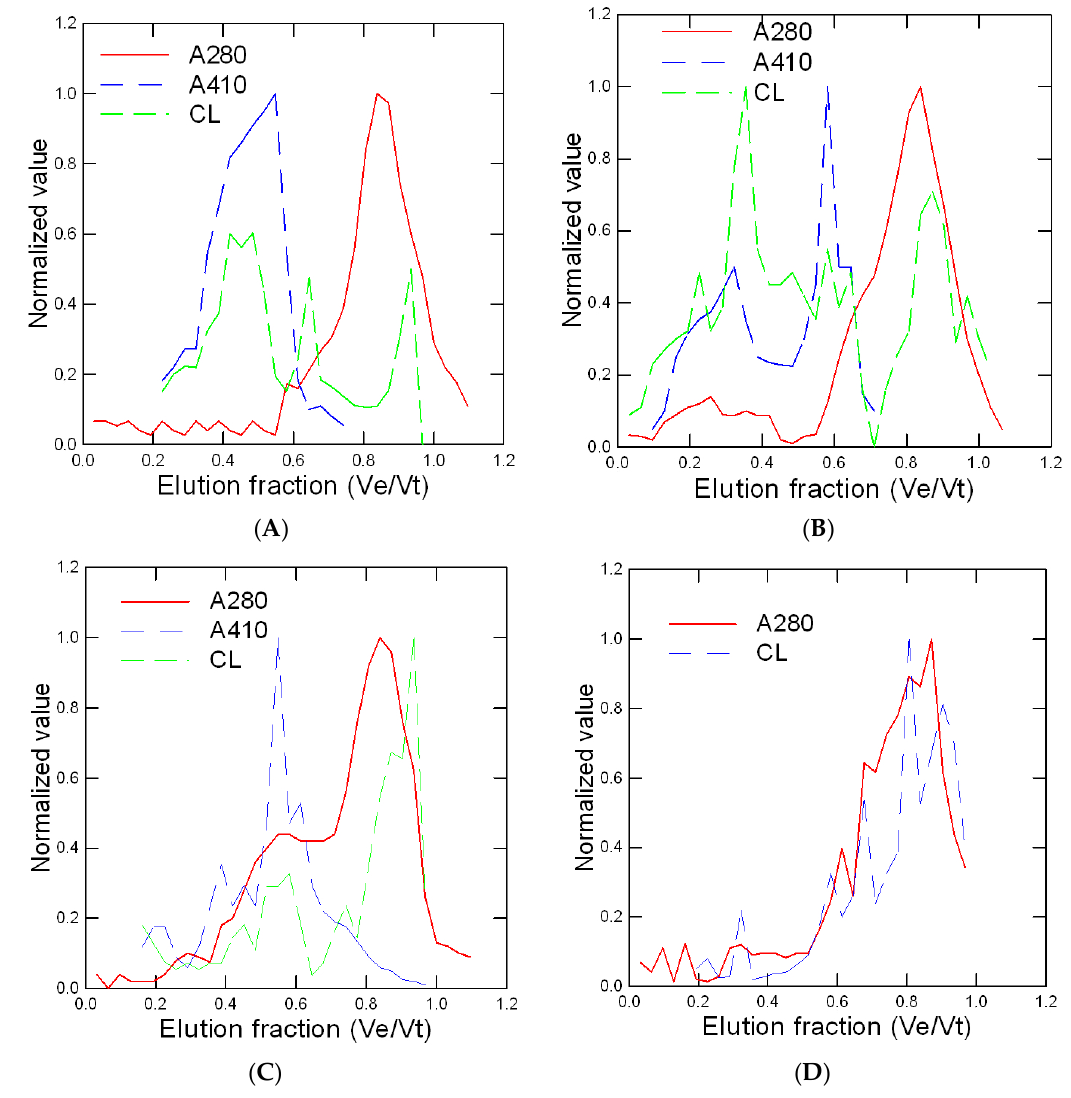
Figure 2. Size-exclusion chromatography analysis of gills in fish exposed to various forms of Ag. The gill homogenate fractions were analyzed by size-exclusion chromatography on a 40 × 1 cm Sephacryl S500 column using 1 mM NaCl and 0.2% Tween-20 as the elution media for spherical ( A ), cubic ( B ), and prismatic ( C ) nAg and dissolved Ag ( D ). The samples were analyzed by a size-exclusion chromatography column pre-calibrated with polystyrene NP (100, 50, and 20 nm diameter), albumin, and NaCl (total volume). The abscissa axis is defined by Ve/Vt, where Ve is the elution volume and Vt is the total column volume (as determined by NaCl). The data were normalized to 1 (fraction signal − min signal)/(max signal − min signal) for ease of measurement for comparisons of each chromatogram. Table 1. Stability of Ag in the exposure media.